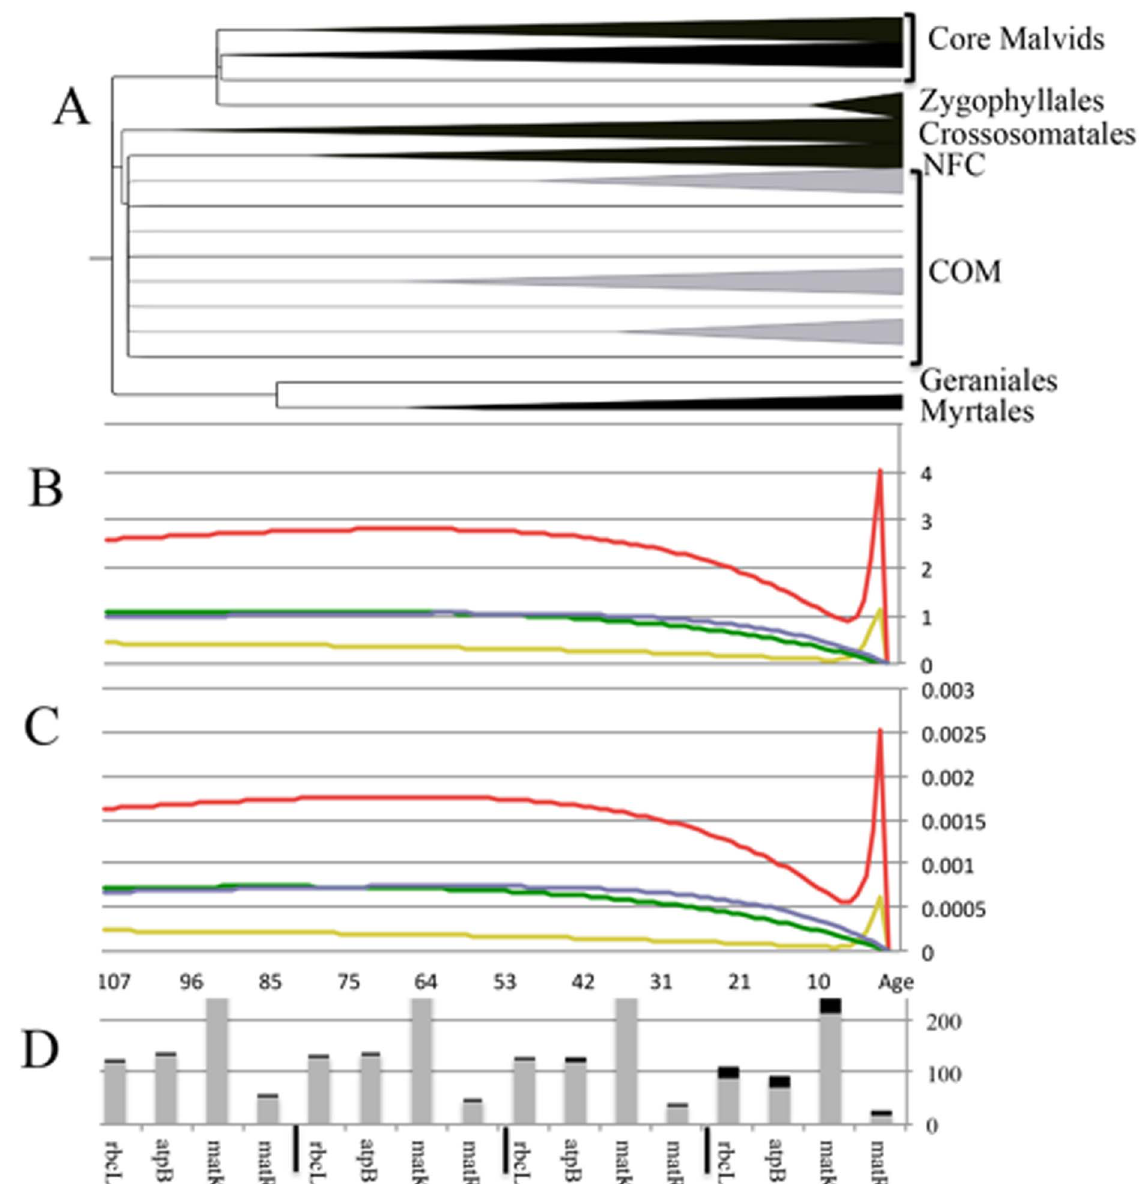
Figure 5. Rosids ultrametric reconstructed in PATHd8 and the informativeness profiles estimated in PhyDesign along with their variability at different epochs of rosids history. (A) Ultrametric tree for the rosids calculated in PATHd8 based on the concatenated four-gene data set. (B) Net informativeness profiles for matK (red), matR (yellow), rbcL (blue), and atpB (green) gene partitions; (C) Per-site informativeness profiles for the same genes; (D) The mean (gray) and standard deviation (black) for gene informativeness at four equally divided epochs in the evolutionary history of the rosids. COM: Celastrales, Malpighiales, and Oxalidales. NFC: Nitrogen Fixing Clade, Rosales, Fabales, Cucurbitales, and Fagales. Both matK and matR display spikes in their informativeness profiles at very recent